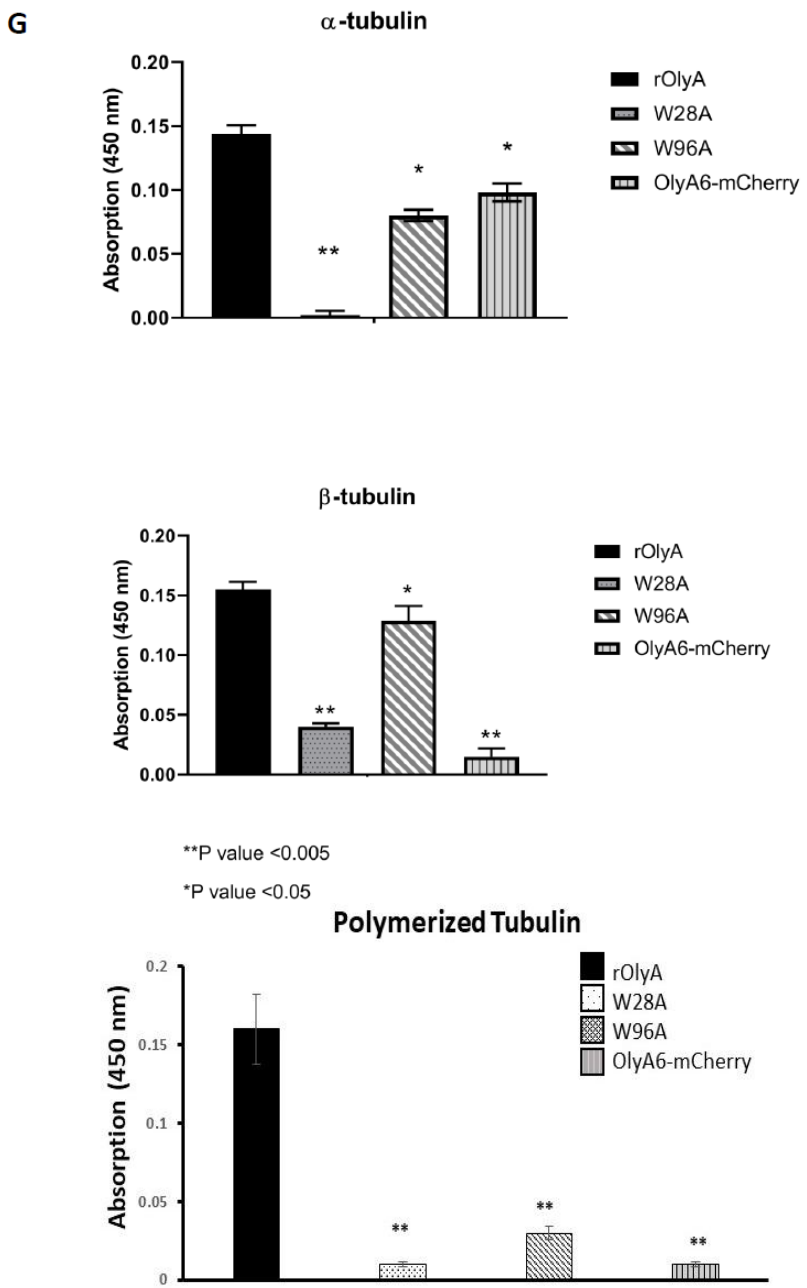
Figure 6. Dynamics of rOlyA protein interaction with β -tubulin after internalization into HIB-1B preadipocytes. DAPI immunostaining for colocalization of rOlyA with β -tubulin in HIB-1B cells after ( A ) 75 min, ( B ) 7 h, ( C ) 12 h, ( D ) 14 h. Zoom-in of the image to emphasize the colocalization. ( E ) Leica-3D tool (Leica Geosystems, Balgach, Switzerland) for colocalization of rOlyA with β -tubulin in HIB-1B cells at 14 h. ( F ) Super-resolution STORM imaging of rOlyA and β -tubulin protein interaction at 14 h. Images of HIB-1B preadipocytes stained with anti- β -tubulin primary antibodies and Alexa Fluor 680 (purple) or rOlyA Alexa Fluor 488 (green). Zoomed-in region of protein colocalization, tagged nanoclusters. Scale bars in zoomed-out images = 2 µ m and in zoomed-in images, 1 µ m and 200 nm. ( G ) Binding of rOlyA, its mutants and OlyA6-mCherry to α -tubulin (top panel) and β -tubulin (bottom panel) in a solid-phase ELISA. rOlyA and its mutants were added to immobilized α / β -tubulin and polymerized α / β -tubulin at 50 ng 100 µ L − 1 well − 1 , rOlyA 50 ng 100 µ L − 1 well − 1 and OlyA6-mCherry 150 ng 100 µ L − 1 well − 1 , reacted with rabbit anti-rOlyA and goat anti-rabbit IgG-HRP. Protein was quantified by measuring OD at 450 nm. * p < 0.05, ** p <